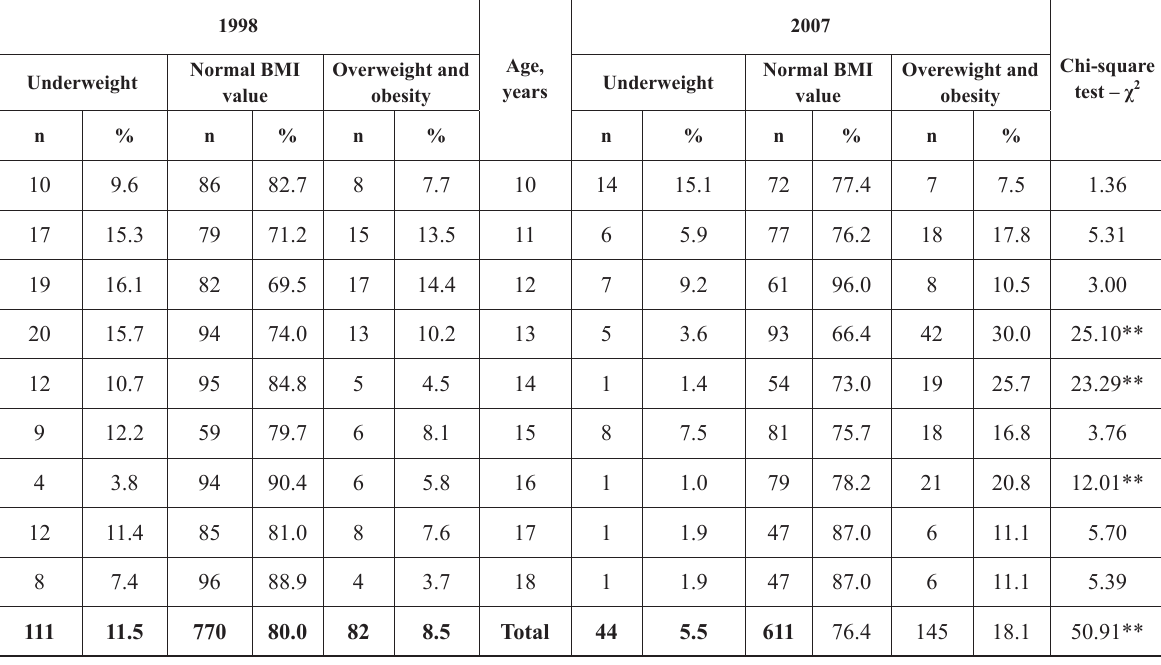
Table 1. Frequency of occurrence of underweight and overweight including obesity in boys during the period of 1998–2007